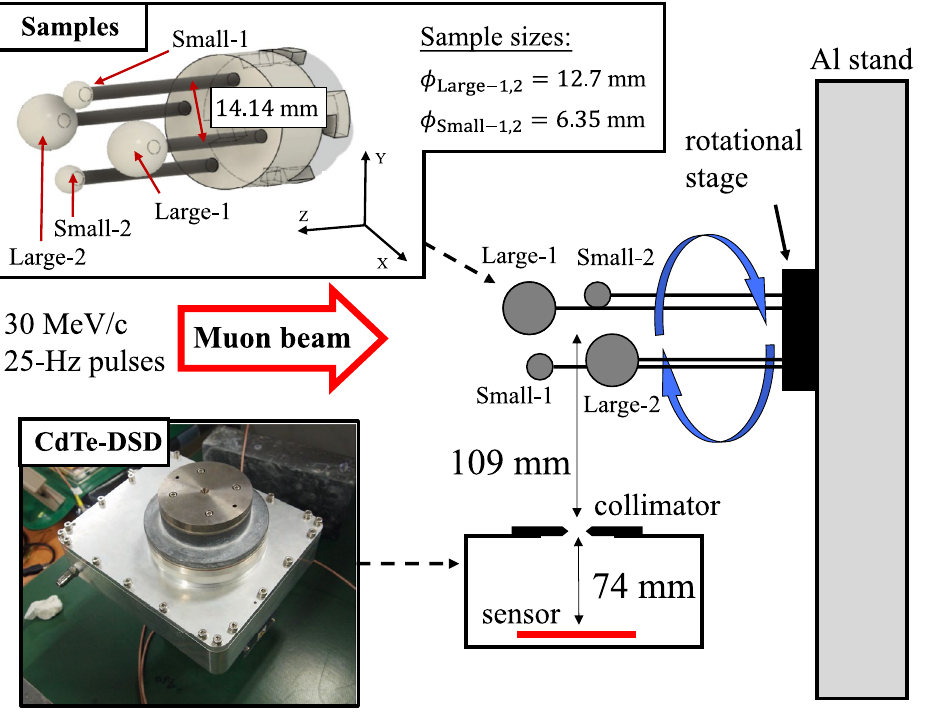
Figure 1. Geometry of the imaging